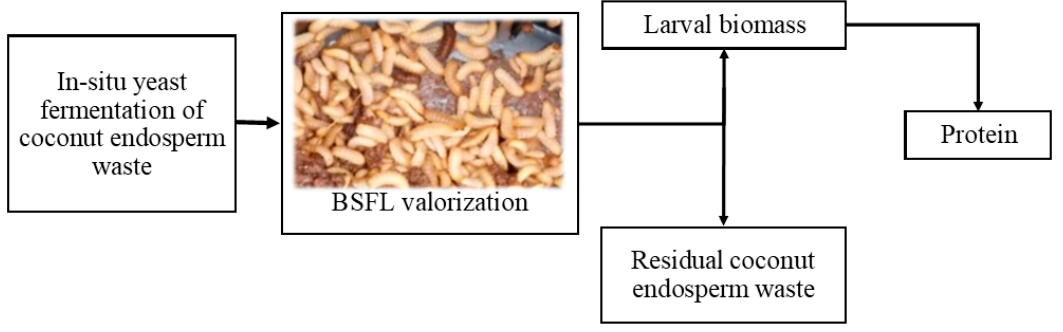
Figure 1. Schematic flow of the experimental procedures.